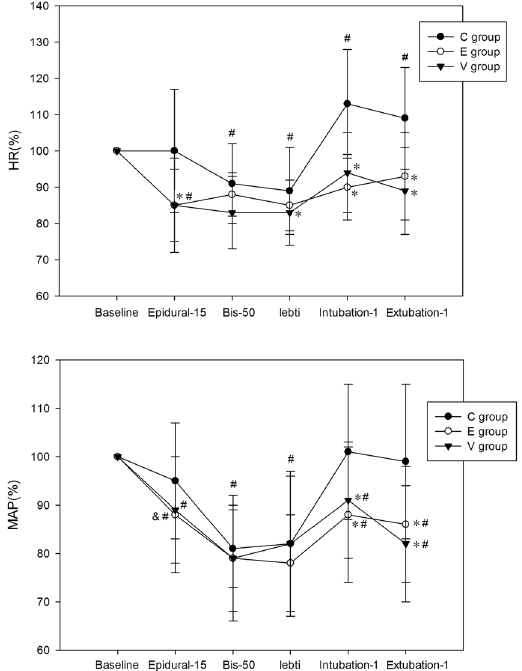
Figure 3. Changes in HR and MAP in the Groups C, E and V. HR, heart rate; MAP, mean arterial pressure; Epidural-15, 15 min after epidural or intravenous infusion of dexmedetomidine; BIS-50, at the time of the BIS level of 50; Lebti, the time before tracheal intubation; Intubation-1, 1 min after intubation; Extubation-1, 1 min after extubation. Measurements were recorded at baseline, Epidural-15, BIS-50, Lebti, Intubation-1, and Extubation-1. * compared with Group C, p < 0.01; # compared with baseline, p < 0.01; & compared with Group C, p < 0.05.